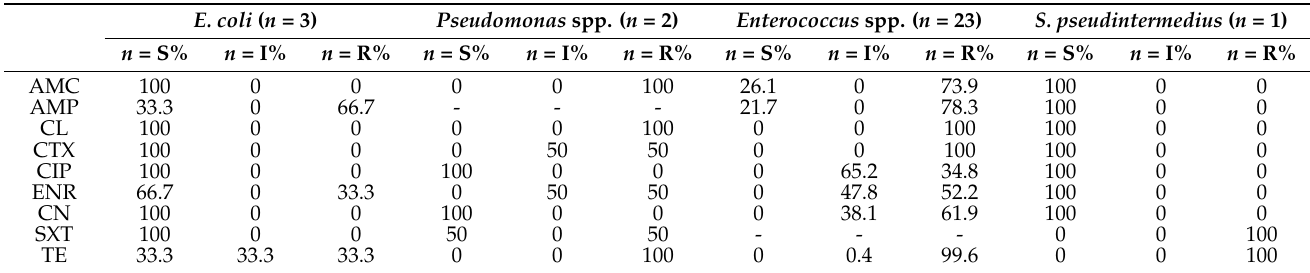
Table 1. Results from the antimicrobial susceptibility tests of all isolates under study ( n = 29), with corresponding susceptibility and resistance rates for each antibiotic